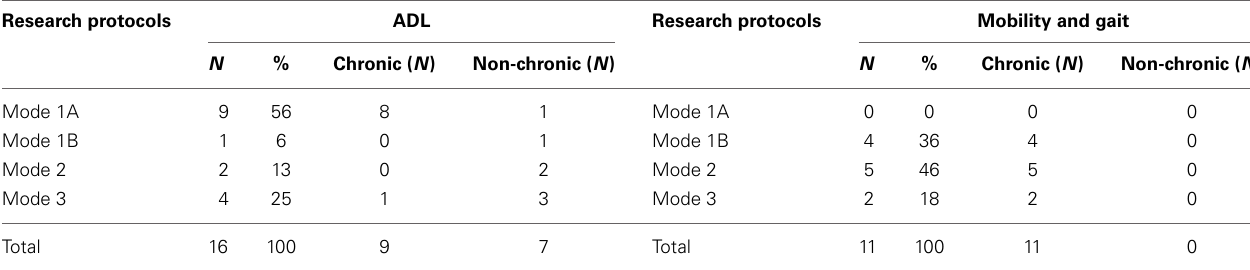
Table 2 | Modes of MI delivery in the research protocols of the 27 clinical studies reviewed. Research